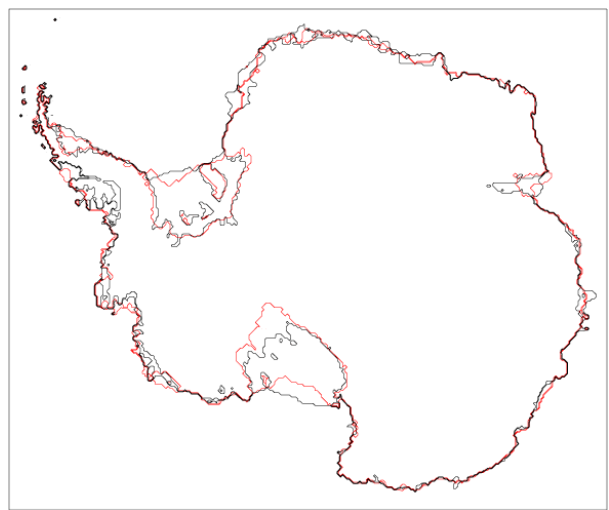
Fig. 6. Comparison of grounding-line and ice-front positions from ALBMAP dataset (black) and PISM-PIK dynamic equilibrium sim- ulation